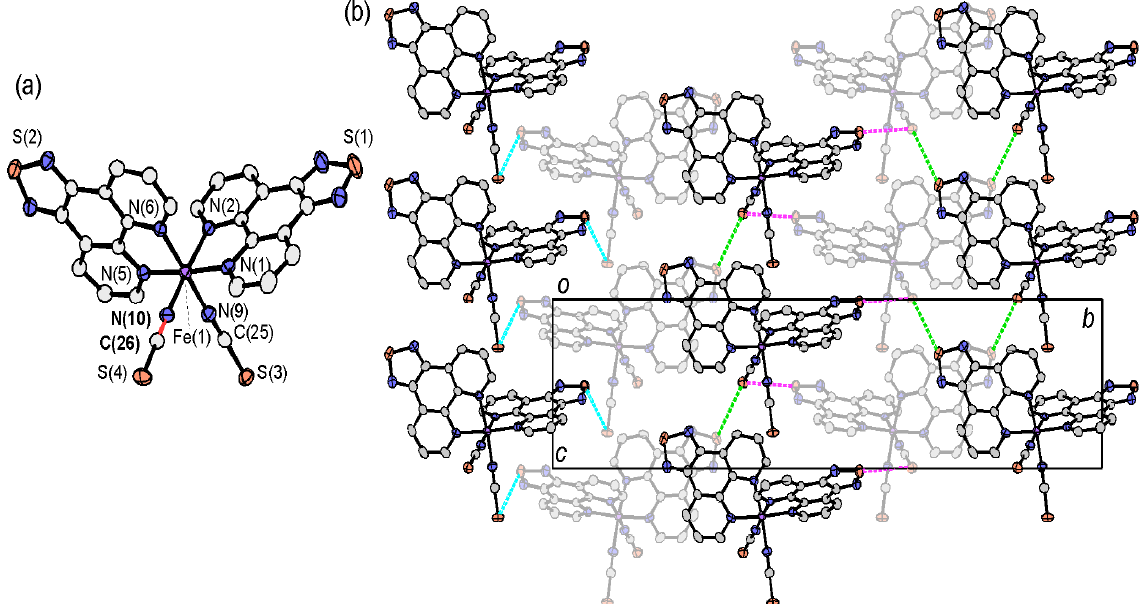
Figure 4. Three-dimensional network structure of solvent-free [Fe(tdap) 173 K [53]. Adapted by permission of The Royal Society of